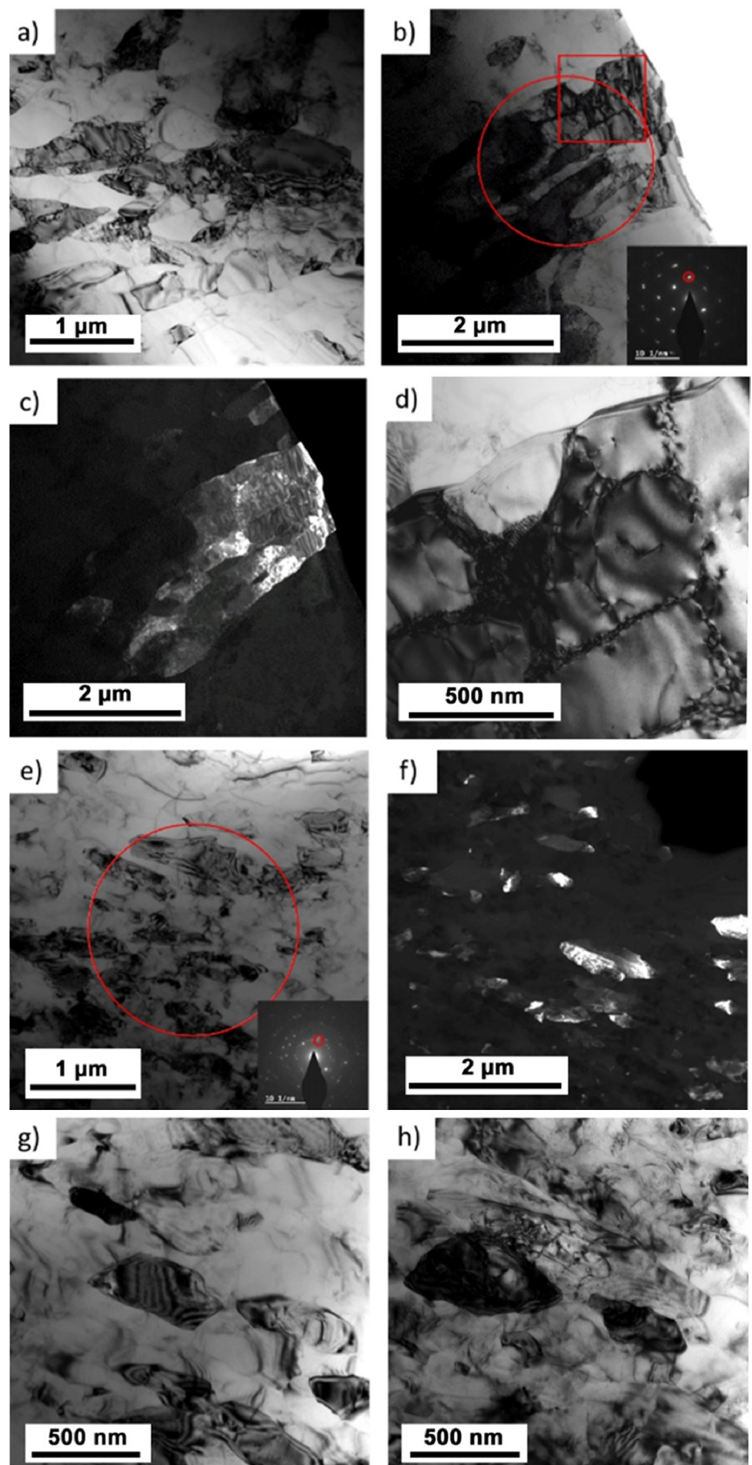
Figure 8. TEM images of the microstructures of the samples processed with stationary mandrel ( a – d ) and of the sample processed with rotating mandrel ( e – h ).